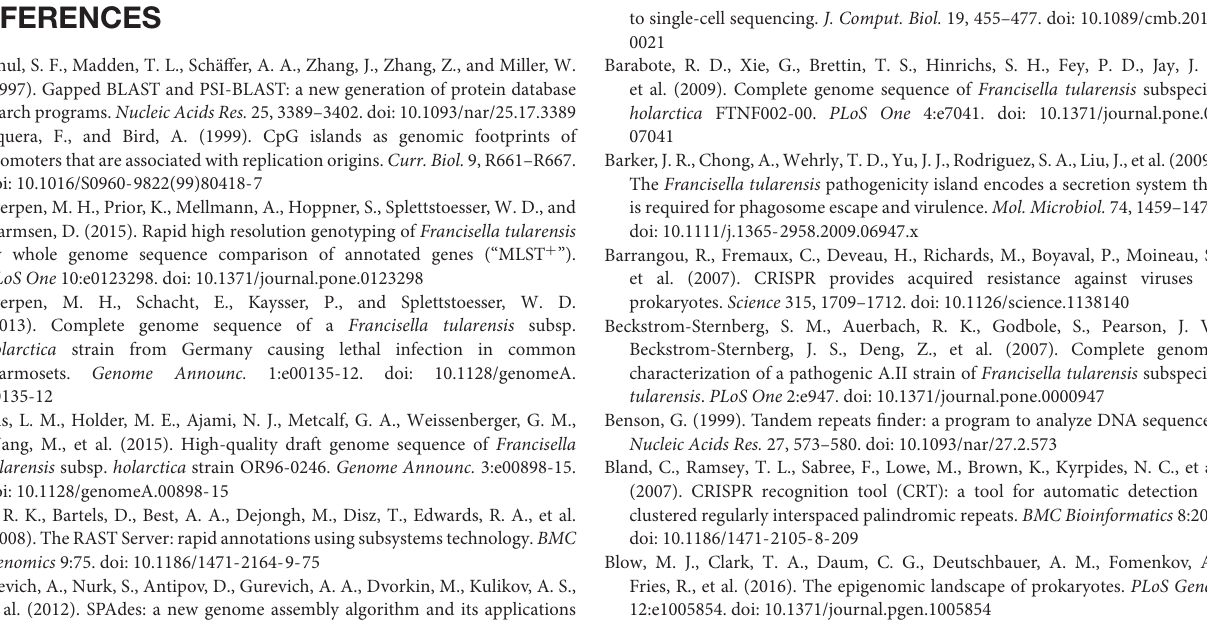
FIGURE S1 | Bioinformatics pipeline. TABLE S1 | Comparison of assembler preprocessing with bbduk and sickle and assembler comparison of the 12T0050 assembly with SPAdes, AByss, MaSuRCA and CLC. TABLE S2 | Predicted CpG island with number of methylated sides and percentage CpG island prediction with standard settings of EMBOSS, with an average methylation percentage between 12–40% the predicted methylation sides are significantly methylated, but for most of them no known proteins were